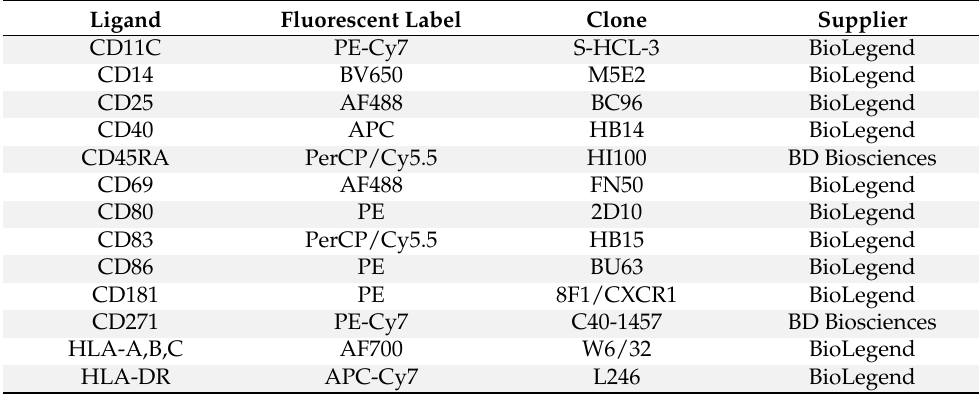
Table 1. Fluorescently-labeled monoclonal antibodies used in this study.